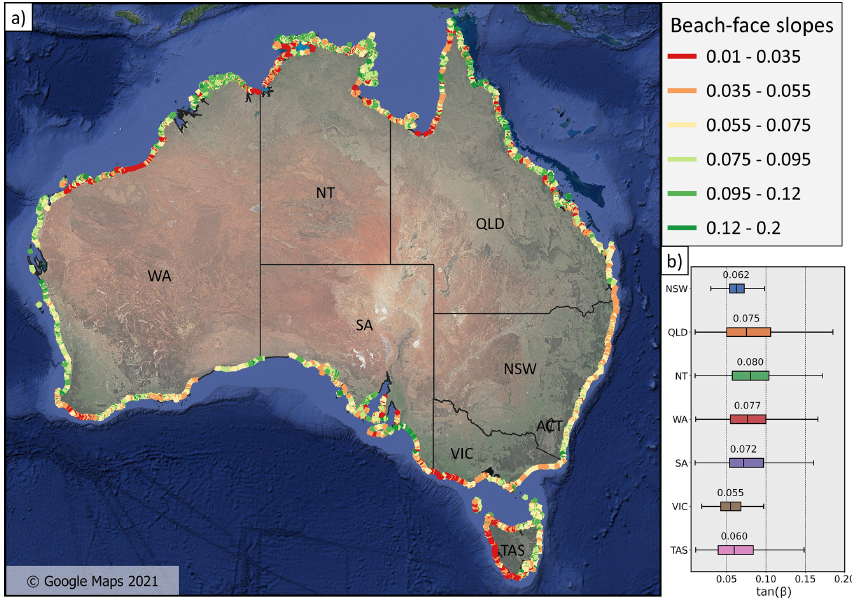
Figure 4. Beach-face slopes around Australia along 132000 100m-spaced transects (equivalent to 13200km of coast). Panel (b) shows the distribution for each Australian